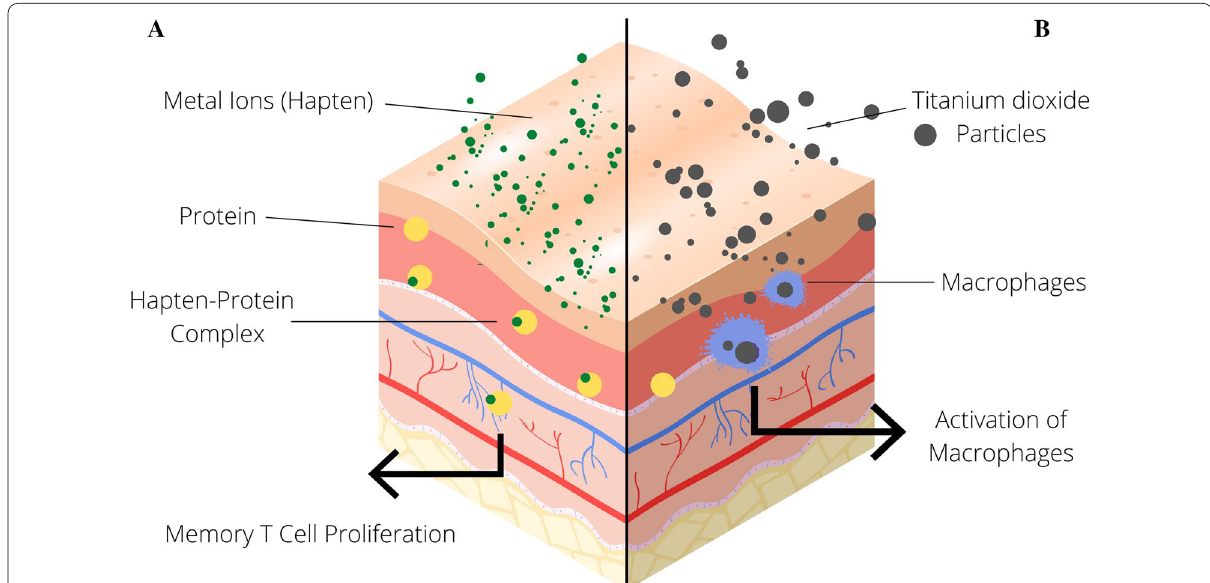
Fig. 3 Immunological mechanism of contact hypersensitivity (Coombs and Gell Type IV) as detected by LTT or ECT ( A ). Oxides, such as titanium dioxides, do not react with proteins and, therefore, do not act as haptens. Titan particles stimulate tissue macrophages ( B